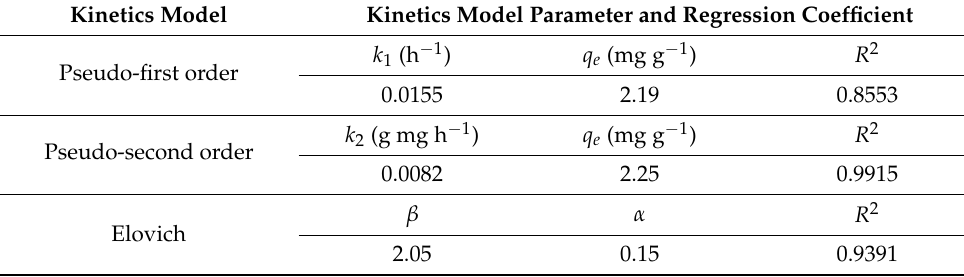
Table 2. Kinetics model parameters and regression coefficients for ciprofloxacin the adsorption by biosorbent made of pecan